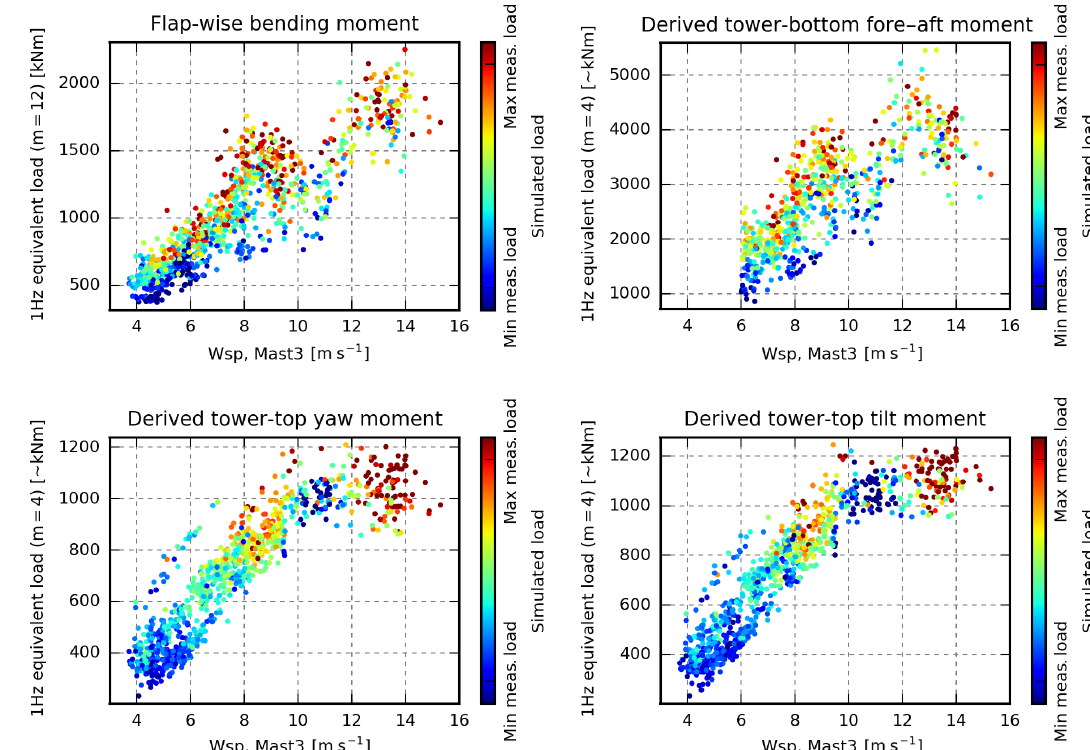
Figure 18. Equivalent measured loads, coloured by the corresponding simulation result. The simulations are performed using inflow infor- mation from the met masts similar to Case 2 (but only one seed per period). If the simulated load equals the maximum measured load at the current wind speed, then the observation is red, whereas observations where the simulated load equals the minimum load measured at the current wind speed are